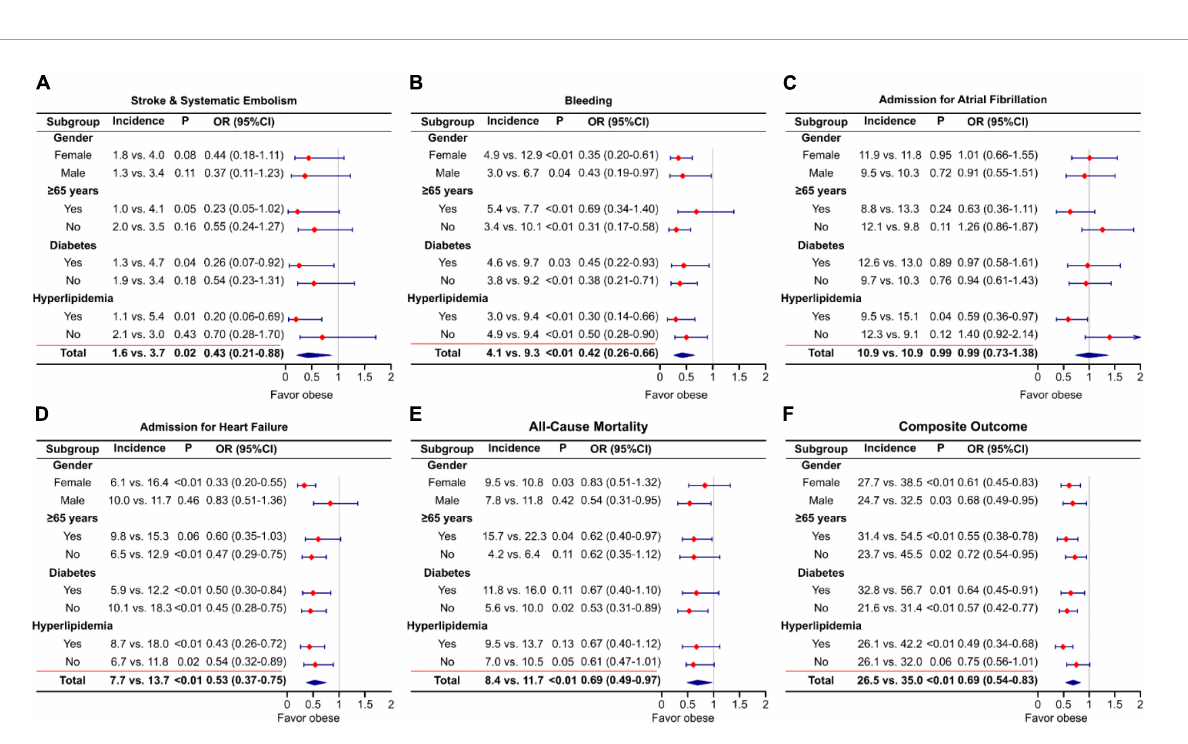
FIGURE3 Odds ratio and forest plots of outcomes [ (A) stroke and systematic embolism; (B) bleeding; (C) admission for atrial fibrillation; (D) admission for heart failure; (E) all-cause mortality; (F) composite outcome] in subgroups of